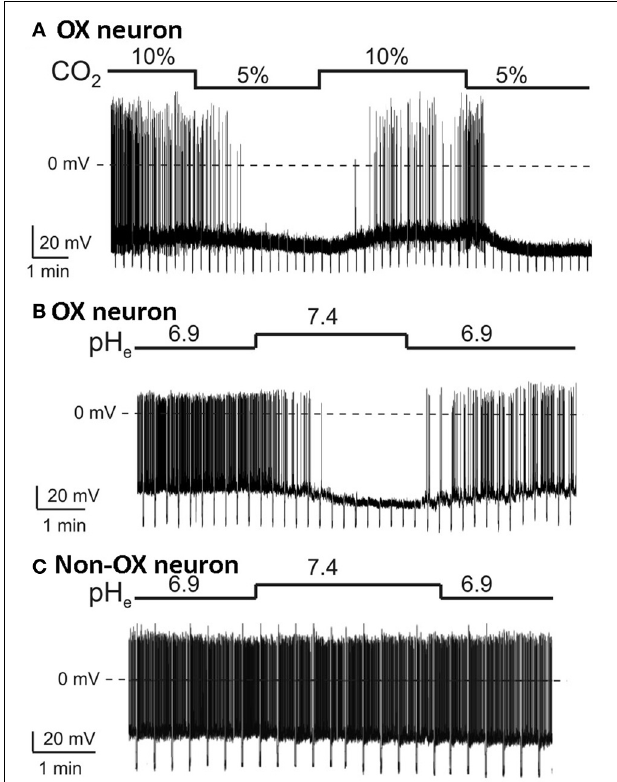
FIGURE 8 | Orexin neurons in LHA are intrinsically CO 2 and pH sensitive. In vitro current-clamp whole-cell recordings of GFP tagged orexin neurons of the Phox2b-eGFP mice show: (A) orexin (OX) neurons are intrinsically CO 2 chemosensitive, Firing rate was 0.8 ± 0.3Hz in 5% CO 2 and increased to 3.7 ± 0.4Hz in 10% CO 2 ( n = 5; P < 0 . 01); (B) orexin neurons are intrinsically pH chemosensitive. Firing rate was 4 ± 0.6Hz at pH 6.9 and decreased to 0.5 ± 0.2Hz at pH 7.4 ( n = 15; P < 0 . 001); and (C) non-orexin neurons in the same region are not pH chemosensitive. (Figure used with permission from Williams et al., 2007).